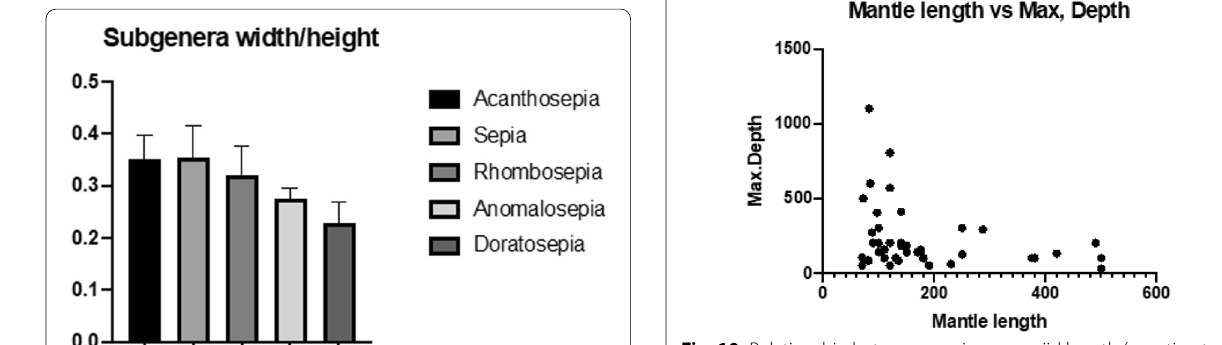
Fig. 10 Relationship between maximum sepiid length (as estimated by mantle length measurement for individual species) and maximum depth habitation. From these data, it appears that larger sepiids are restricted to shallower habitat